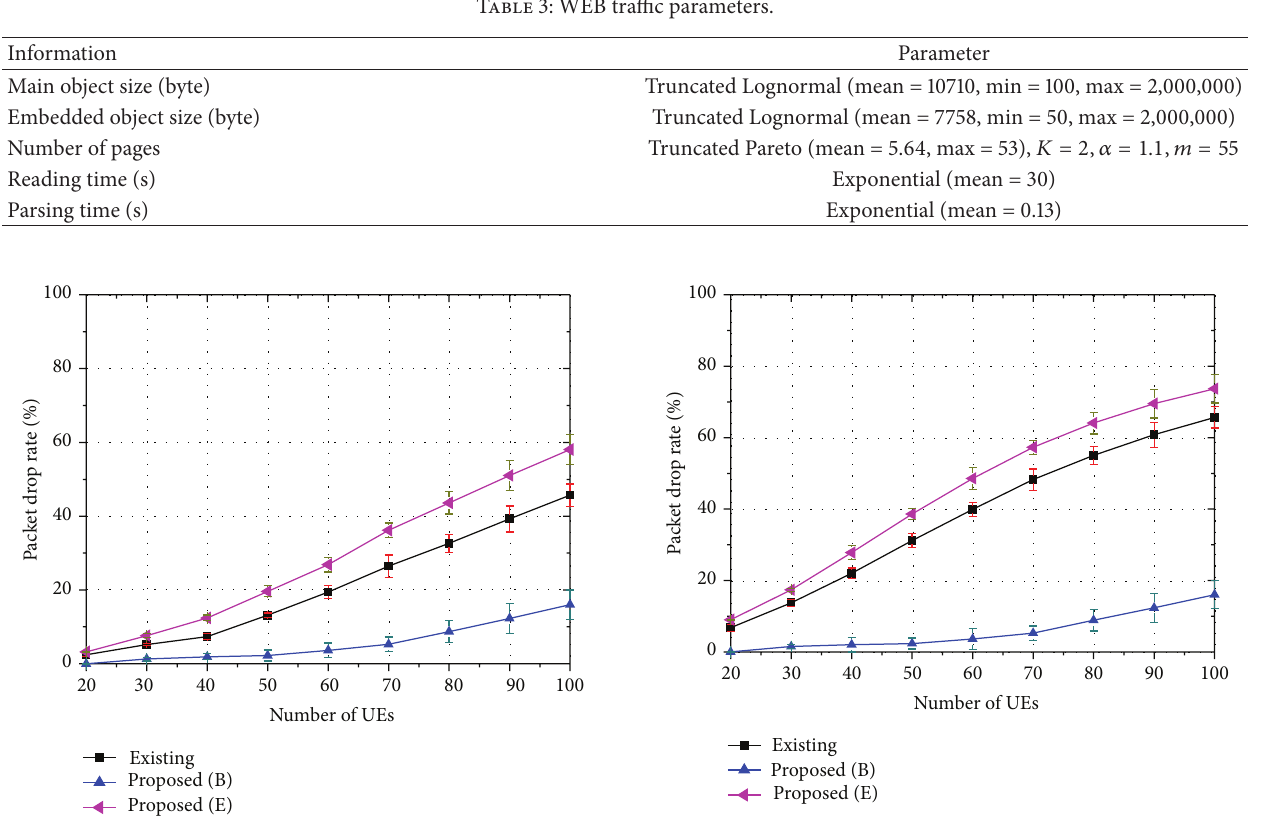
Figure 6: Packet drop rate of 32-viewpoint 3D A/V traffic ( 𝛽 = 1.8